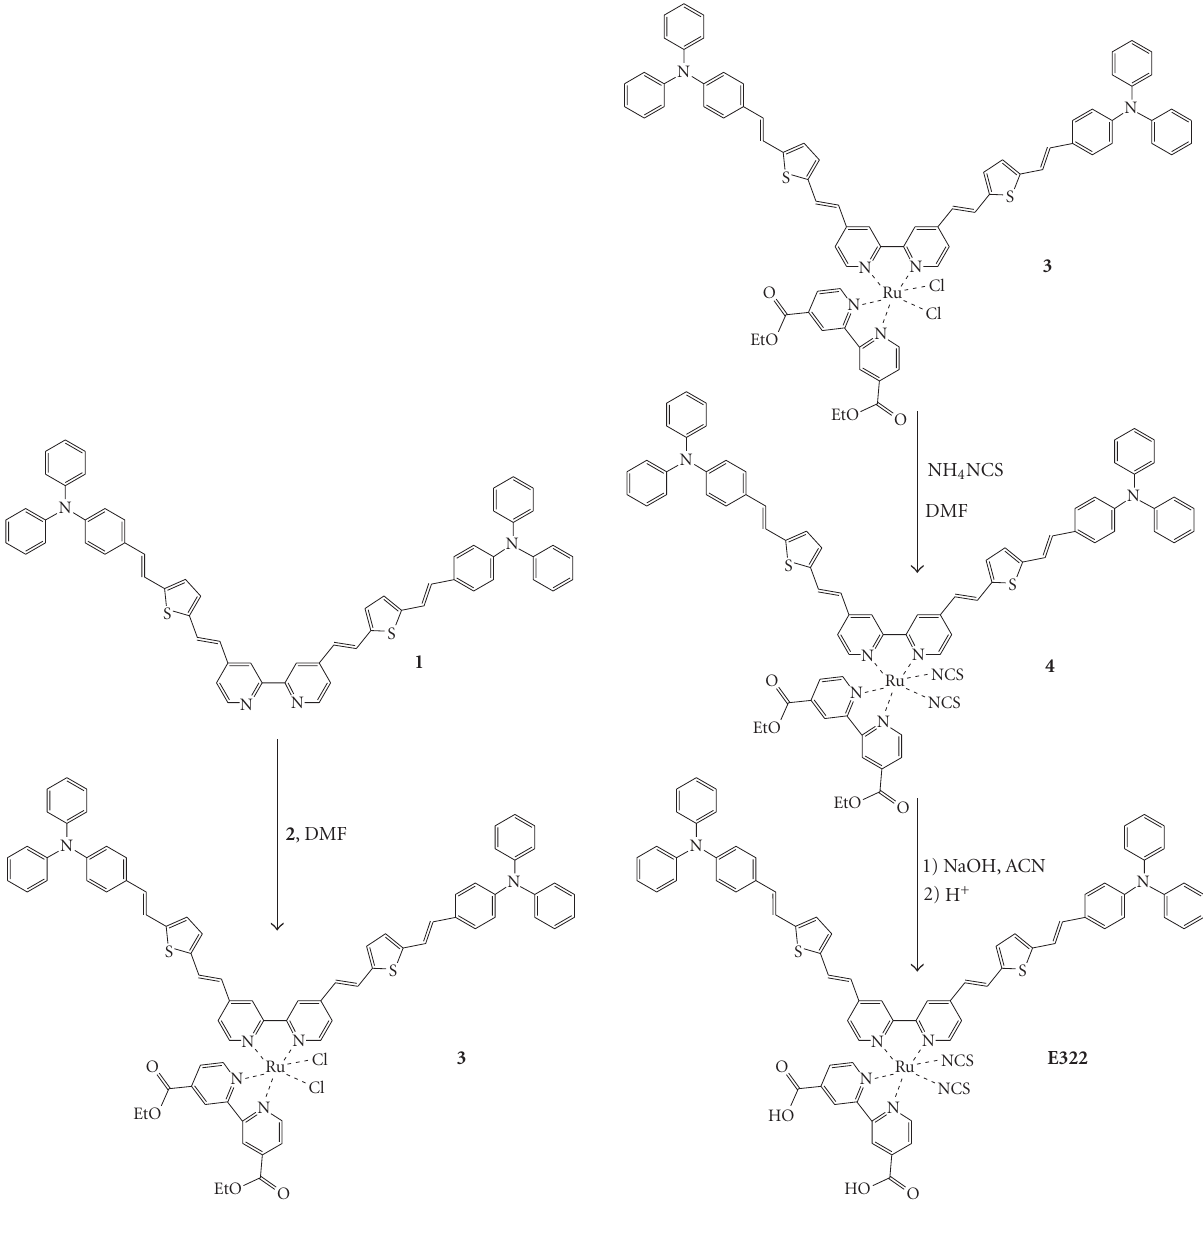
Scheme 1: Synthesis of